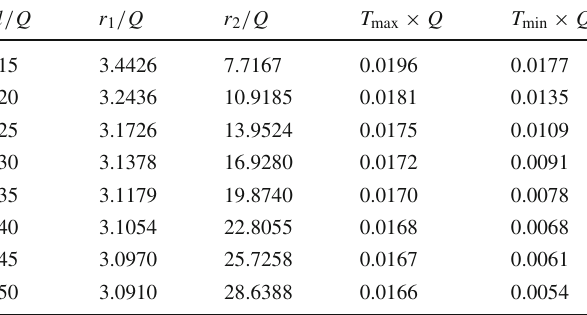
Table 1 The numerical results of Eq. (50) and the second-order phase transition temperatures for the different values of l / Q l /